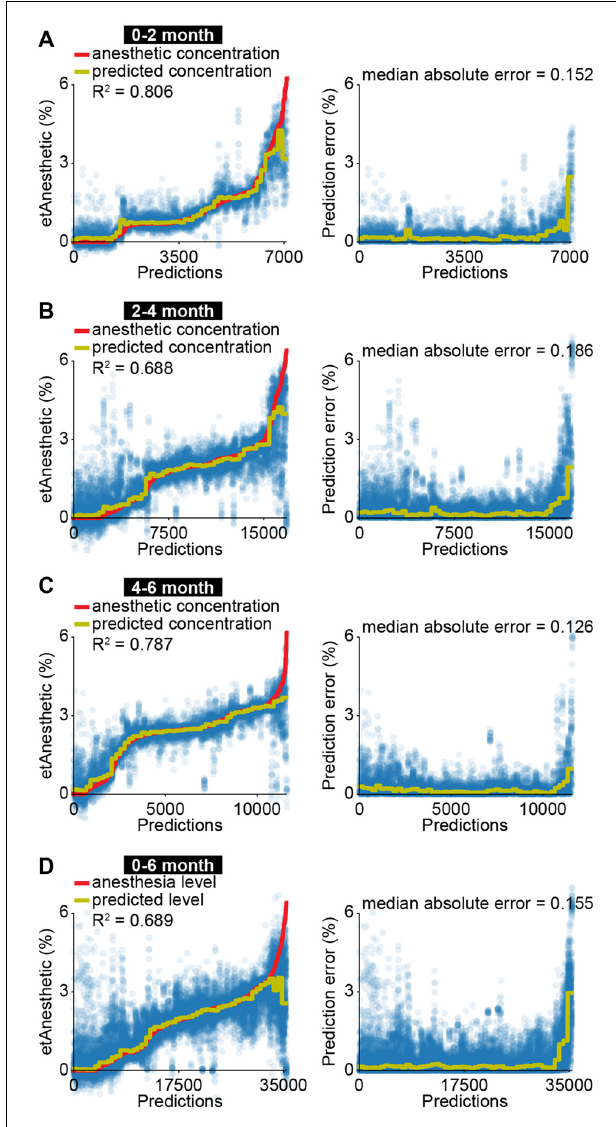
FIGURE 4 | EEG activity is predictive for anesthetic concentration in human infants. (A) Scatter plots displaying measured anesthetic concentration and predicted anesthetic concentration of support vector regression for all predictions (left) and absolute difference between measured and predicted anesthetic concentration (right) for human neonates of 0–2 months. (B) Same as (A) for human infants of 2–4 months. (C) Same as (A) for human infants of 4–6 months. (D) Same as (A) for human neonates and infants of 0–6